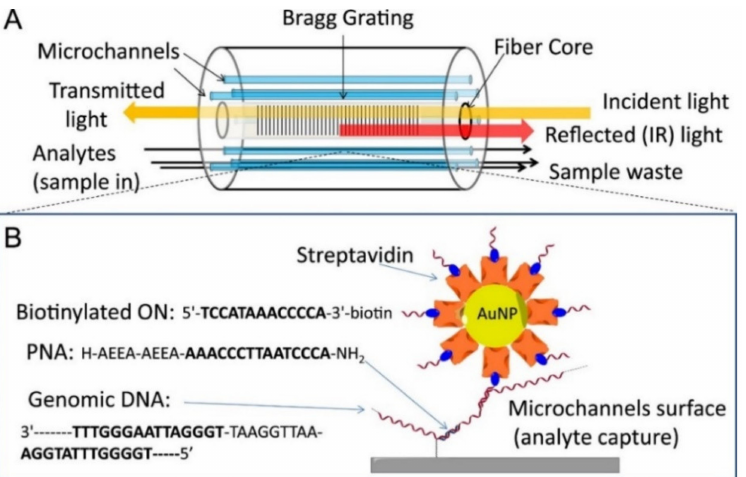
Figure 10. Biosensing with modified LMA-10 fiber. ( A ) Schematic of the optical setup: analytes are infiltrated from one end into the channels surrounding the fiber core. Light is coupled at the opposite end to the fiber core and the reflected light is collected from the same side. ( B ) Sequences of PNA, tar- get DNA tract and oligonucleotide loaded on the AuNPs, and scheme of hybridization on the surface of the fiber channels: capture of streptavidin-coated AuNP bearing a biotinylated oligonucleotide tail on the captured genomic DNA. Reprinted with permission from Ref. [80]. Copyright 2015